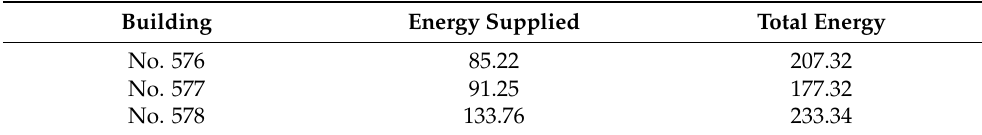
Table 4. Energy Consumption Values in kWh/(m 2 .y) Before Reconstruction.